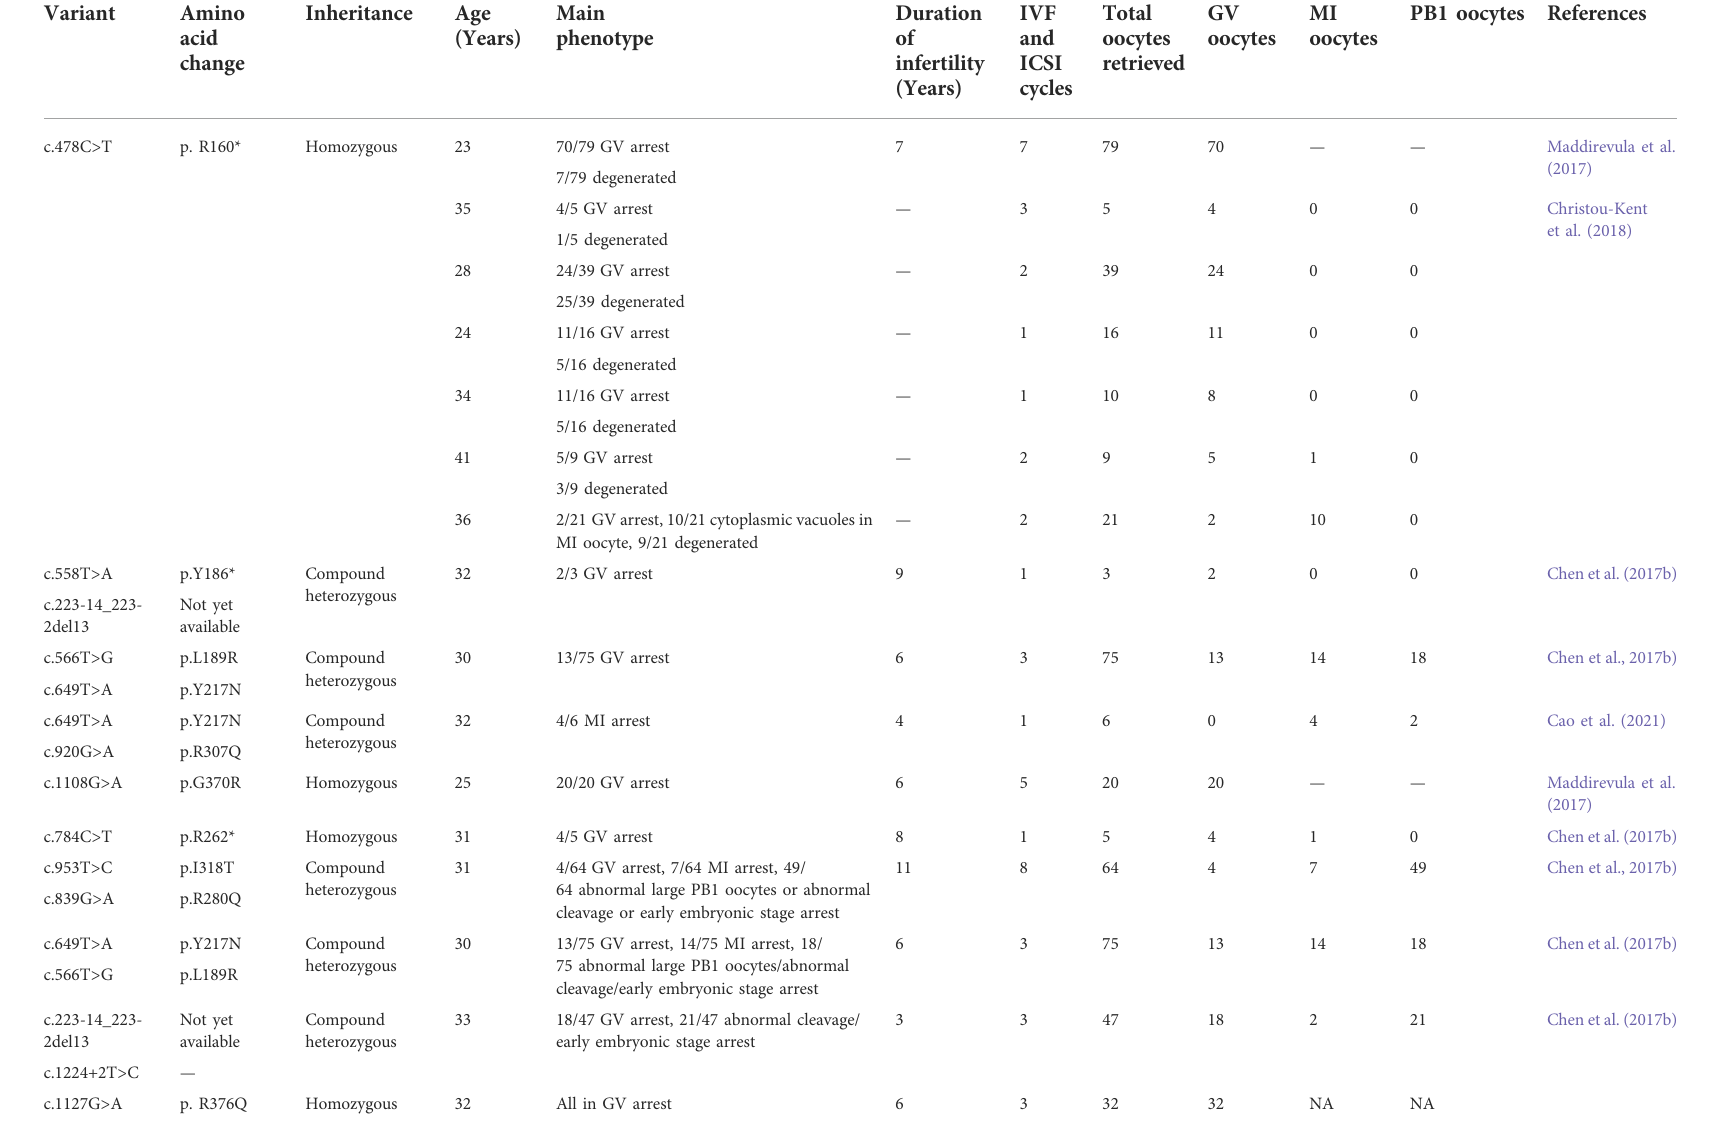
TABLE 2 Characteristics of patients with PATL2 variants and results of IVF